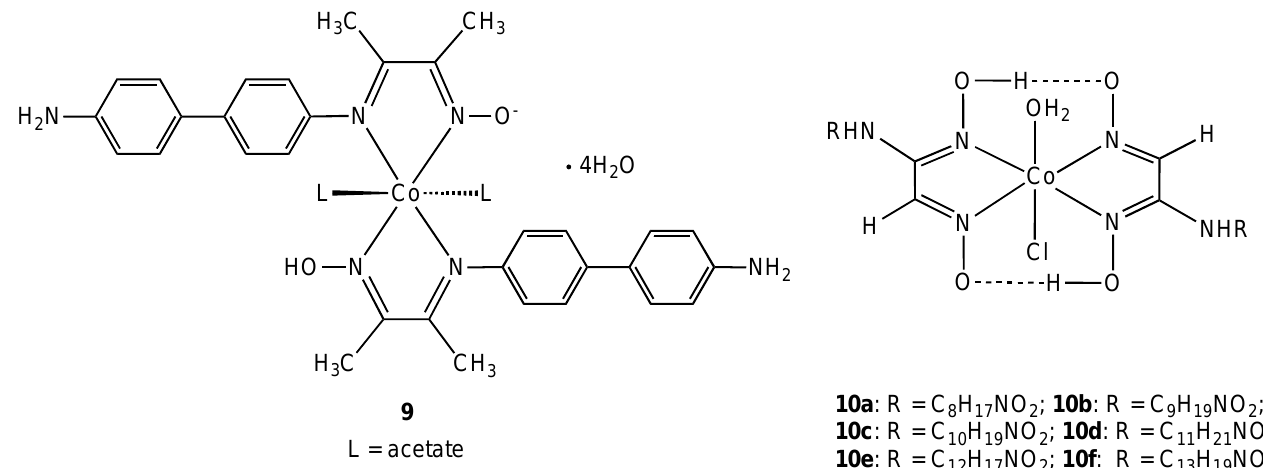
Figure 6. Oxime cobalt(III) complexes 9 and 10 .